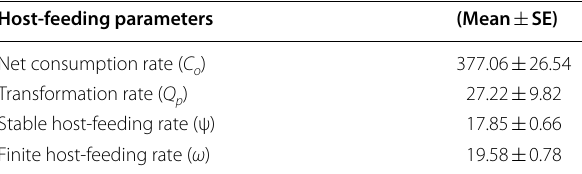
Table 4 Host-feeding parameters of S. pyrastri on cabbage aphid, B.